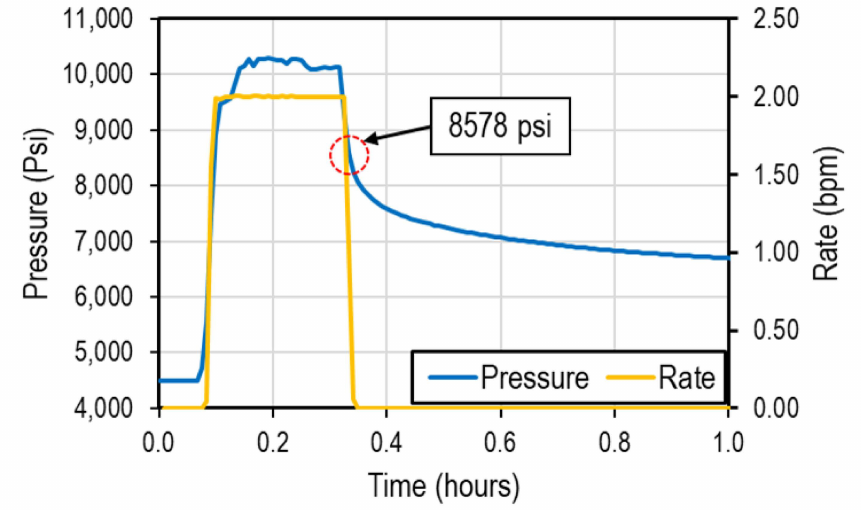
Figure 9. DFIT pressure evolution during injection and after shut-in for Well #1 (Woodford